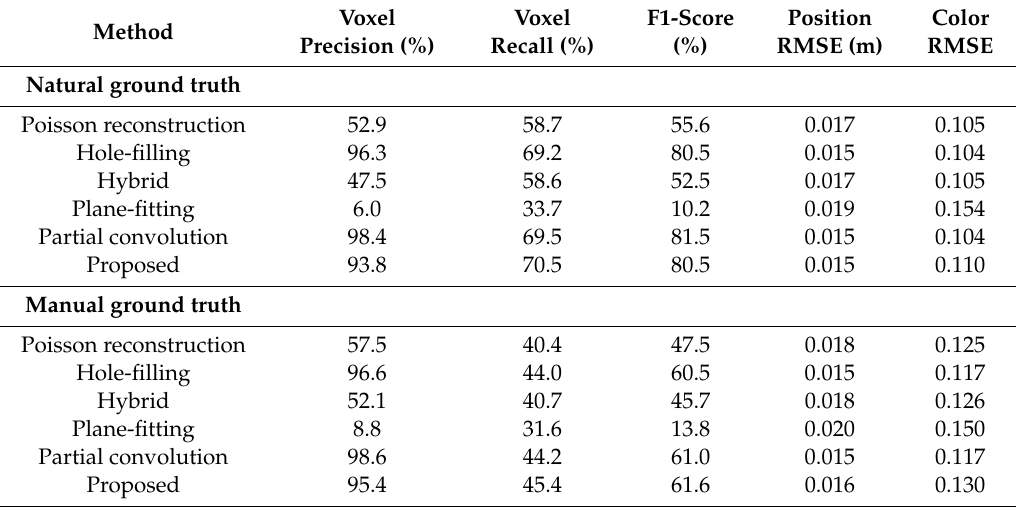
Table 6. Performance comparison between using natural ground truth and manual ground truth for the Pettit building scene.